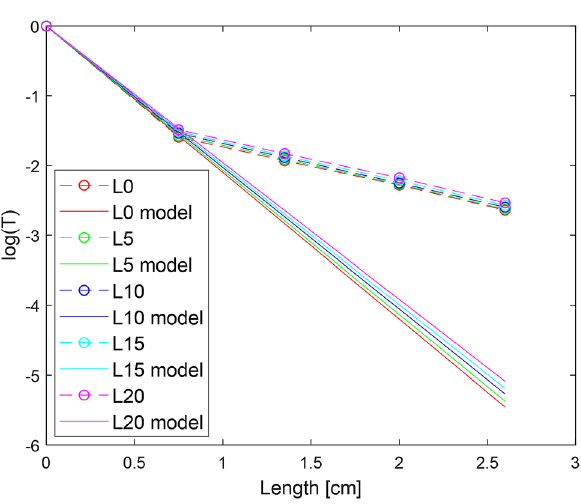
Figure 5. Results of measurements made for different thicknesses of tissue, where X axis represents topological order and Y axis transmission. Graph a is for tissue thickness of 0.75 cm, graph b for tissue thickness of 1.35 cm, graph c tissue thickness of 2.0 cm, graph d tissue thickness of 2.6 cm.